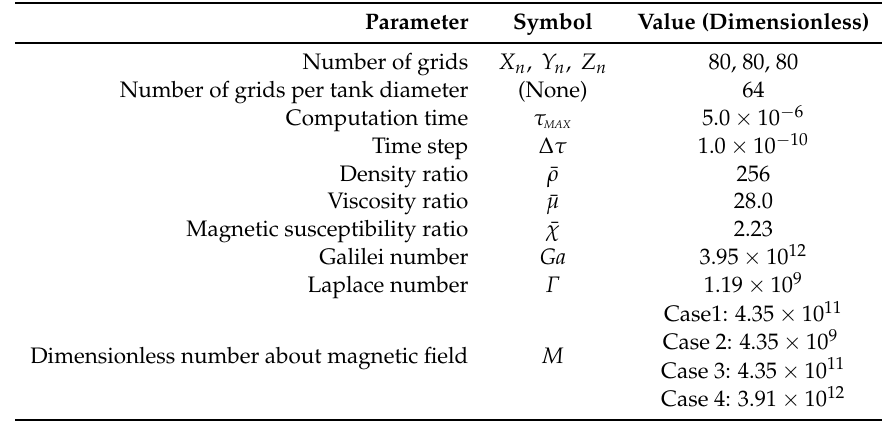
Table 3. Dimensionless computational conditions.